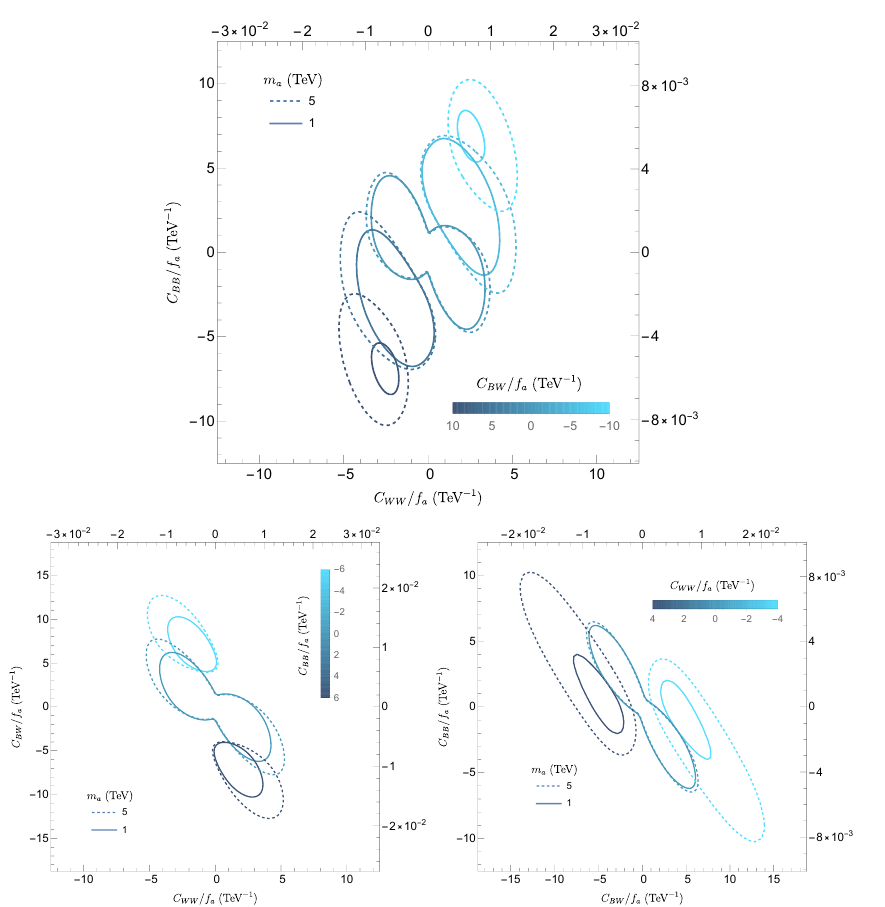
Figure 13 . Combined projected 2 σ constraints in various parameter subspaces at a 14-TeV muon collider with L = 10 ab − 1 . Solid contours: m a = 1 TeV. Dashed contours: m a = 5